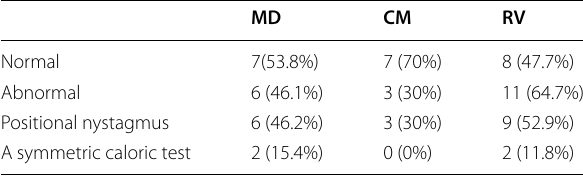
Table 9 Positional nystagmus and the asymmetric caloric